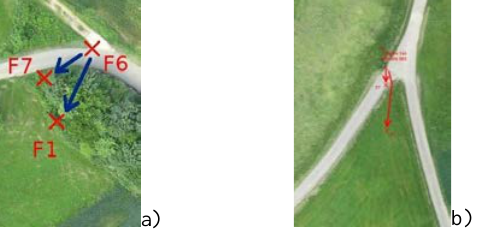
Figure 8: Results of BezF1, BezF6 and BezF7 with direct geo-referencing at two points. Table 9: Comparison of point 9011 coordinates.